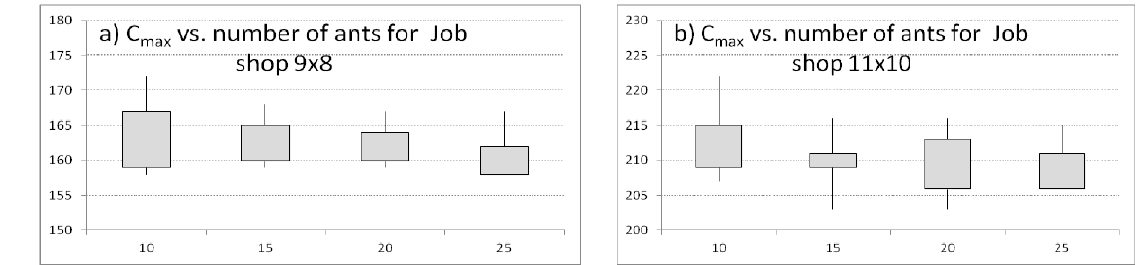
Figure 3. The C max of the basic schedules achieved by the ACO for different iteration numbers. Next, the influence of the number of ants, K = {10, 15, 20, 25} over the quality of basic { } 6.0 == ρα , number of iterations E = {20}, parameter q mone evaporation factor 0 is tion factor α = ρ = 0.8 (Figure 5a). The best scheduel is achieved for C max equals 203 for scheduling problem (11 × 10), for the pheromone evaporation factor α = ρ = {0.4, 0.6, 0.8} non is noticed for both sizes of scheduling problems (9 × 8) and (11 × 10). (Figure 5b).